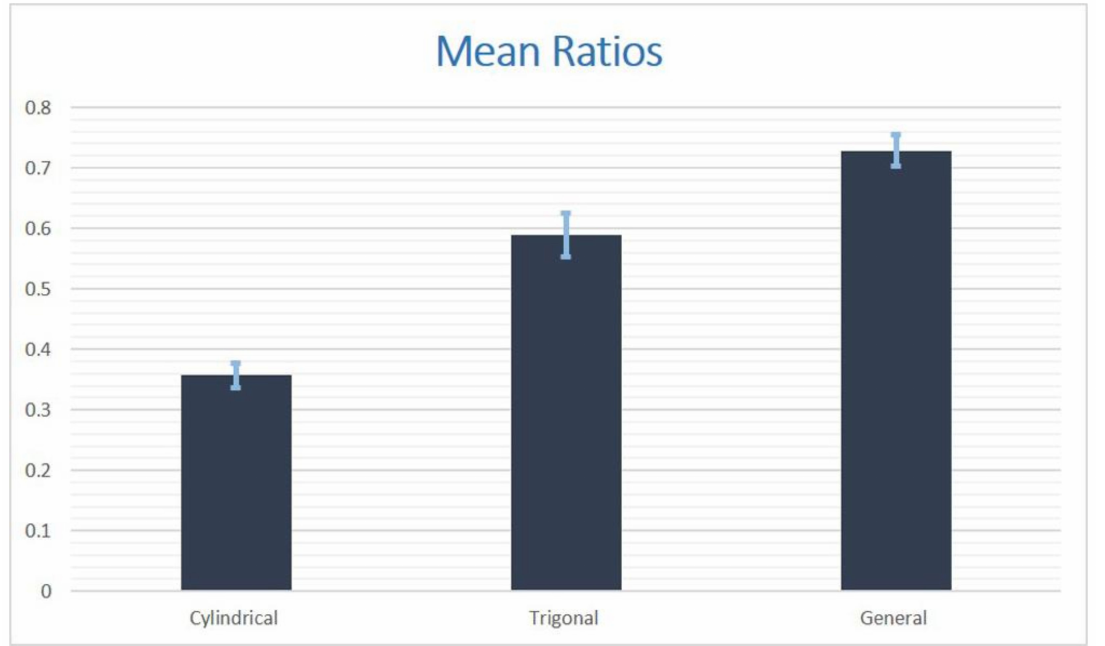
Figure 3. Calculated mean ratio parameter values for the cylindrical, trigonal, and general math- ematical models. The error bars are the standard error of the mean (SEM) for each model. n = 20 measurements from four different